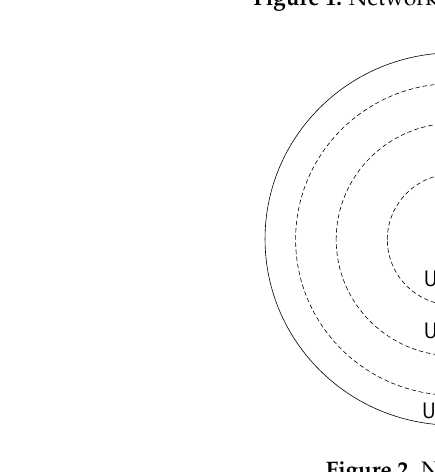
Sensors 2016 , 16 , 26